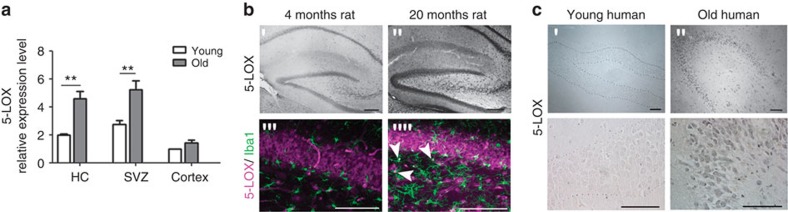
5-LOX expression is upregulated in the hippocampus of old rats and elderly humans.(a) 5-LOX mRNA expression was significantly elevated within the neurogenic regions (hippocampus: 2.4-fold; SVZ: 1.8-fold) of old (20 months) compared to young (4 months) rats (n=3 per group). (b) 5-LOX immunoreactivity was strongly increased in the DG of old ('') compared with young (') rats. Although in young rats 5-LOX staining was predominately allocated to granular neurons ('''), in old rats also Iba1+ microglia ('''', arrowheads) expressed 5-LOX. Pictures illustrate representative 5-LOX stainings; five rats per group were analysed. (c) In elderly humans (>60 years) (''), intensity of 5-LOX immunostaining in the DG was clearly upregulated compared with young persons (<35 years) (') (lower panels show higher magnifications of the dentate gyri depicted in c',''). Images in c illustrate the DG of a 27 year old human person ('), representing the young age group (hippocampi from five persons<35 years analysed), and the DG of a 67-year-old person (''), representing 5-LOX expression in the elderly group (hippocampi from five persons >60 years analysed). Data are shown as mean±s.d.; ** indicates P<0.01; Student's unpaired t-test (a). Scale bars, 100 μm (b,c). DG, dentate gyrus; HC hippocampus; SVZ, subventricular zone.